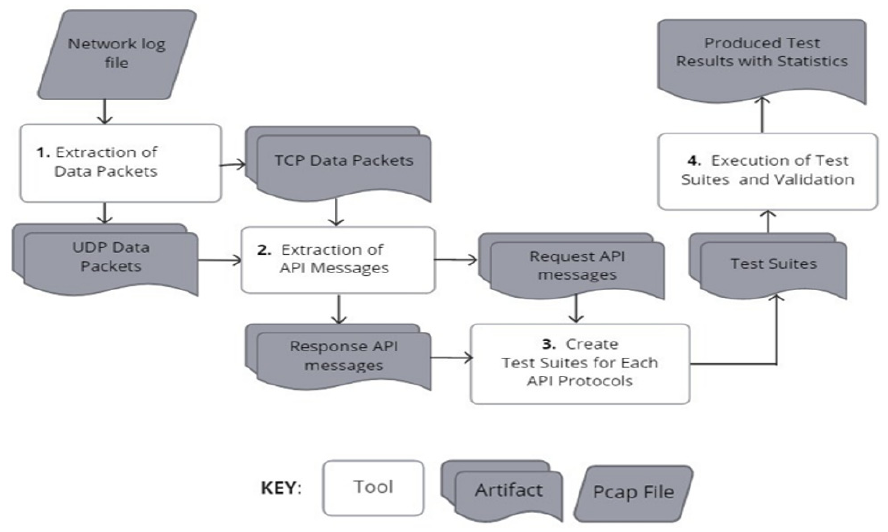
Figure 3. The overall